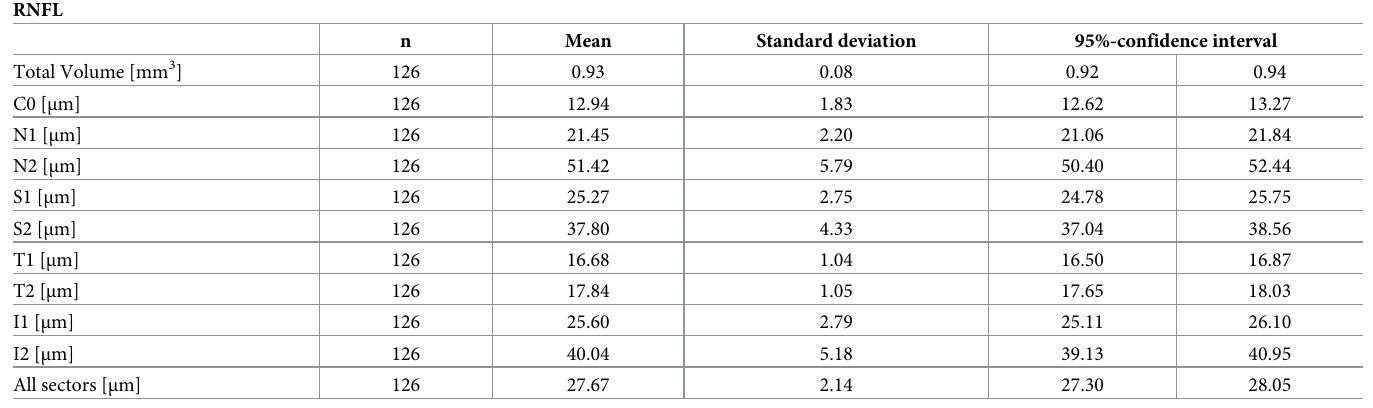
Table 6. RNFL segmentation.